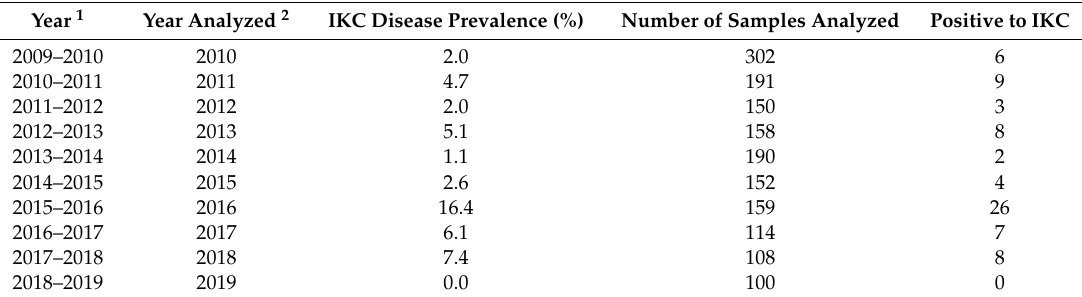
Table 4. IKC prevalence in the Aosta Valley autonomous region (whole region). Data were available for the years